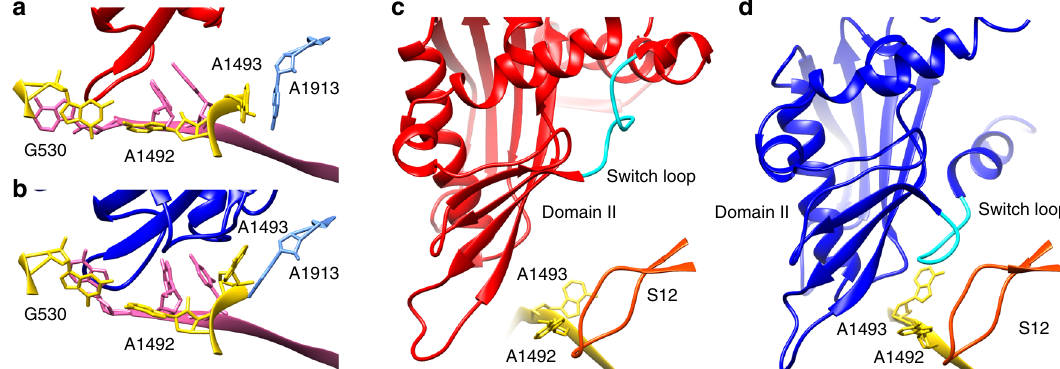
Fig. 3 Interaction of RF1 with the ribosomal decoding center. a , b Structures of the ribosomal decoding center in pre-accommodated ribosome complex ( a ) and accommodated ribosome complex ( b ). Red: compact RF1; dark blue: extended RF1. c , d Conformations of switch loop in pre-accommodated ribosome complex ( c ) and accommodated ribosome complex ( d ). Gold: A1492 and A1493; and orange: H69. A1493 is fl ipped out and stabilizes the fi rst two bases in the A-site stop codon. G530 stacks with the third base A in the stop codon. In the presence of RF, whether compact or extended, A1492 is fl ipped out towards G530 and interacts with the fi rst two stop-codon bases. A1493 stacks with A1913, which is in close contact with A1492 in the RF-lacking termination complex.